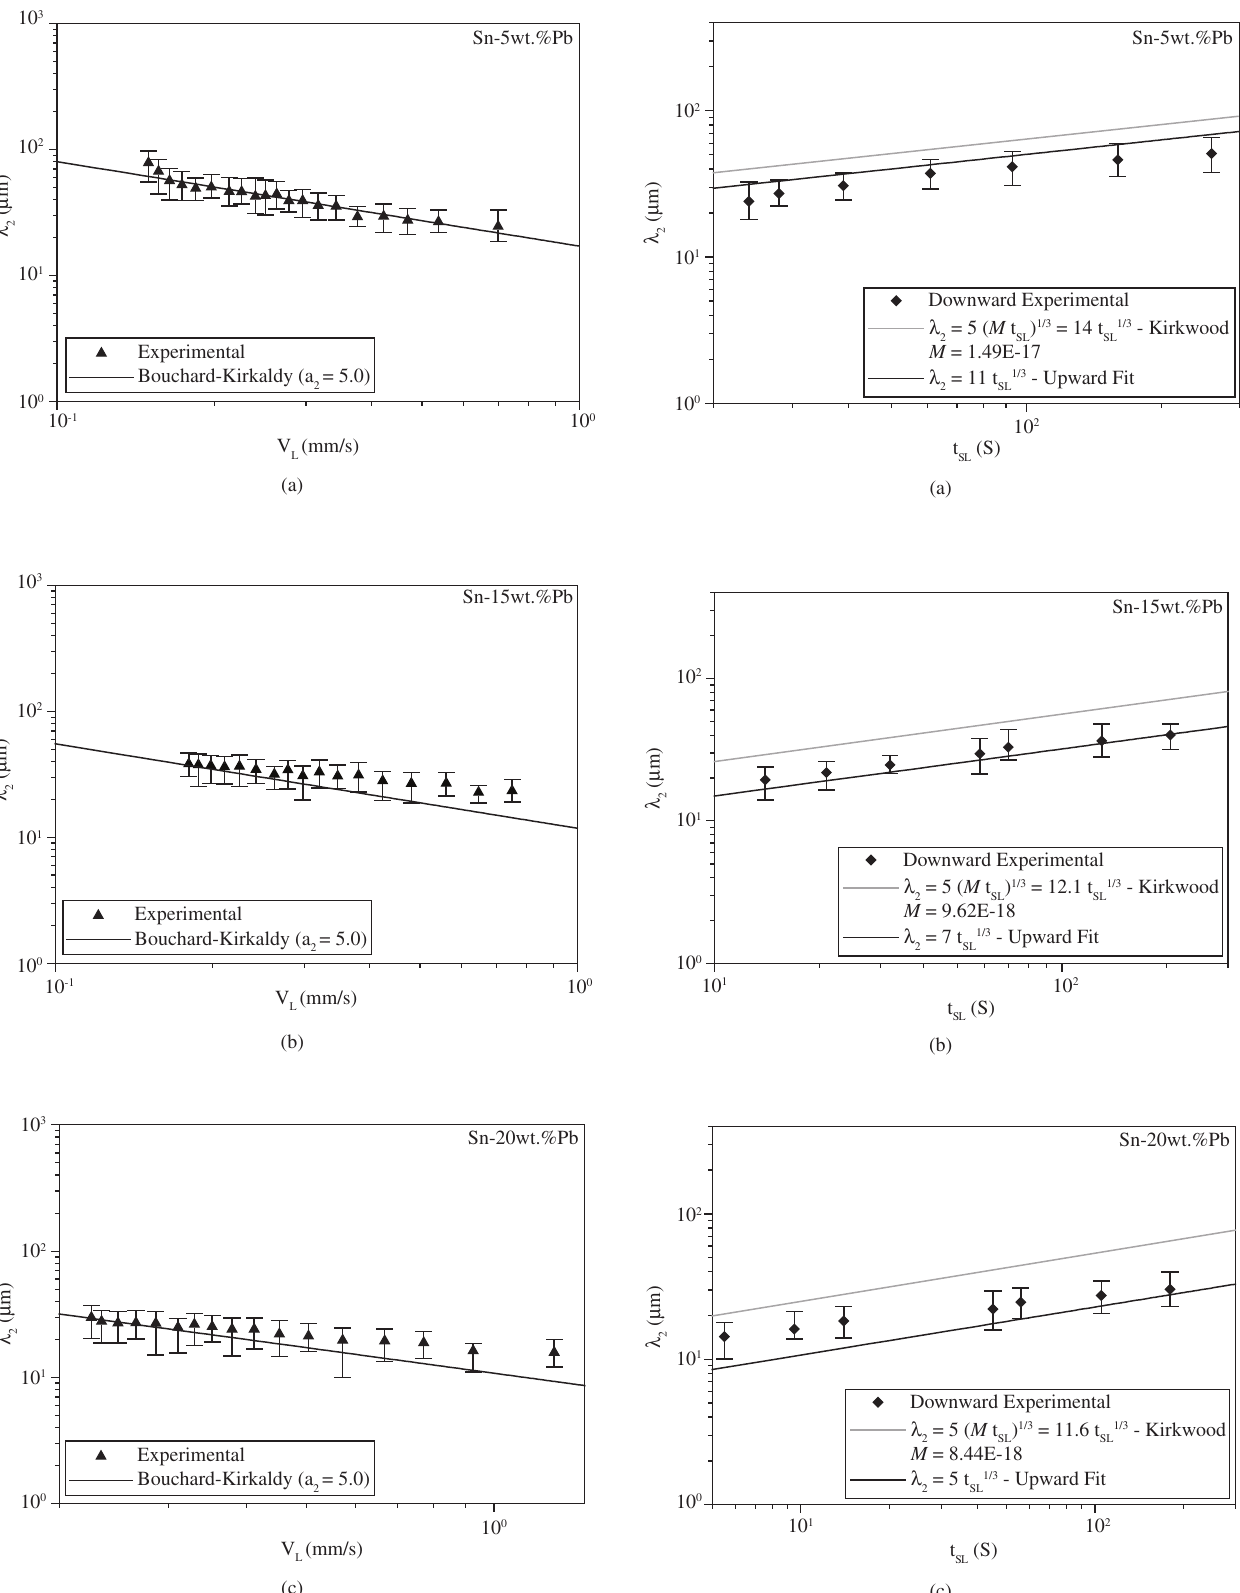
Figure 7. Comparison of experimental and theoretical secondary dendrite arm spacings as a function of local solidification time (t